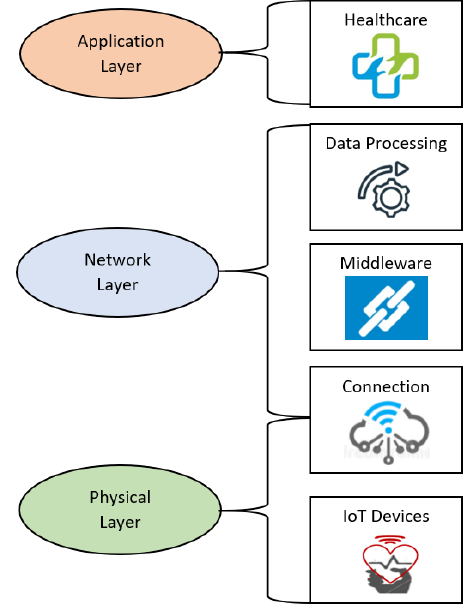
Figure 2. Architecture of IoT layers.